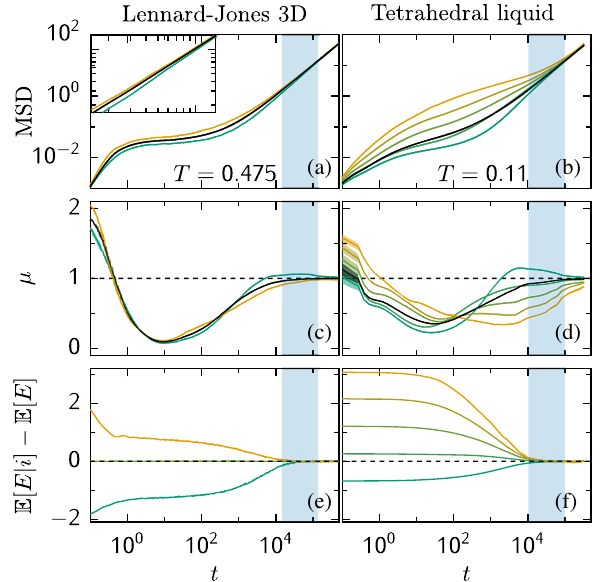
FIG. 5. Dynamics by particle population. Left column cor- responds to the 3D Kob-Andersen binary mixture and shows the time evolution of different observables discriminated into two particle populations: (a) MSD ð t Þ , (c) μ ð t Þ [MSD ð t Þ ∼ t μ ð t Þ ], and (e) difference between the average potential energy of each population E ½ E j i (cid:2) , and the system average potential energy E ½ E (cid:2) . Yellow (green) lines correspond to the population that includes the 1% of the particles with the highest (lowest) potential energy at t ¼ 0 . Right column corresponds to the tetrahedral gelling system and shows the same observables as those appearing in the left column [(b), (d), and (f)]. The five colored lines correspond to the five populations having a different number of bonds ( i ∈ f 0 ; 1 ; 2 ; 3 ; 4 g ) at t ¼ 0 (lines from yellow to green). Black lines in the whole figure represent observables averaged over all particles. The shaded regions mark out the extent of the Brownian yet non-Gaussian time window, where the exponential tail is still detectable and μ ð t Þ ≅ 1 for the total number of particles. Inset in (a) shows a detail of the MSD corresponding to the shaded time window. The chosen temperatures correspond to the deep supercooled regime (3D Kob-Andersen binary mixture) and the Arrhenius regime (tetrahedral liquid). For both systems, the different populations evolve in such a way that the corresponding observables pass from a short-time behavior (where the particles still retain the information of their initial mechanical state) to a long-time regime, where the particles have lost memory of their initial state and the different populations converge to a common